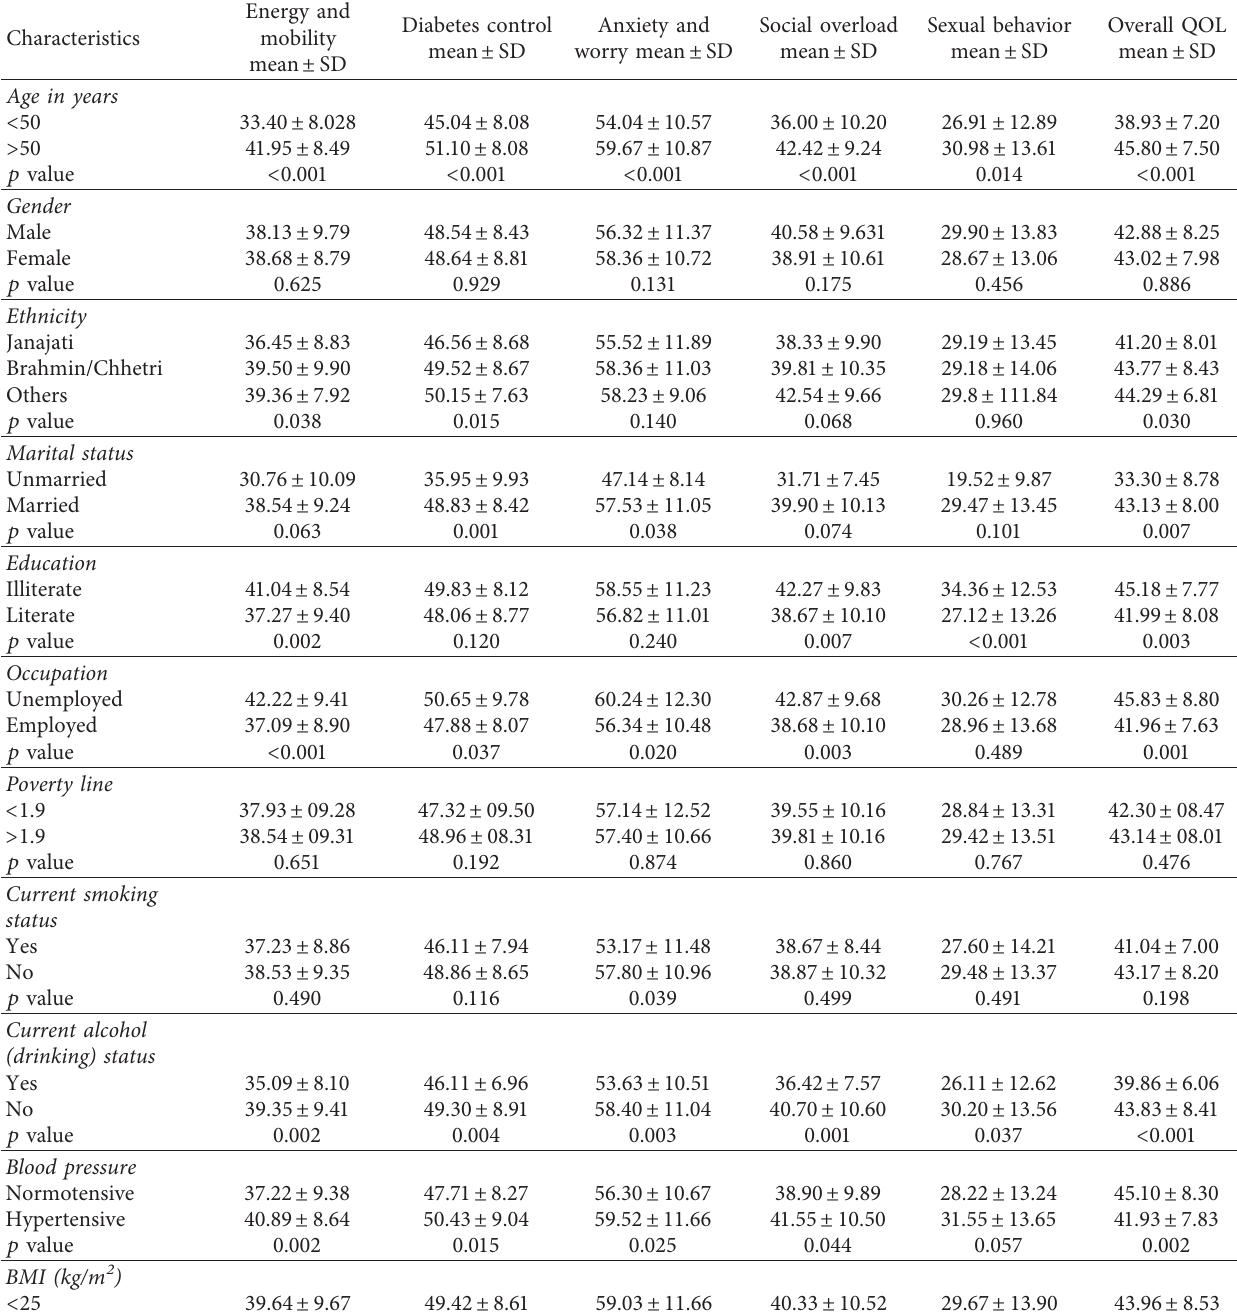
Table 3: Association of demographic characteristics with QOL